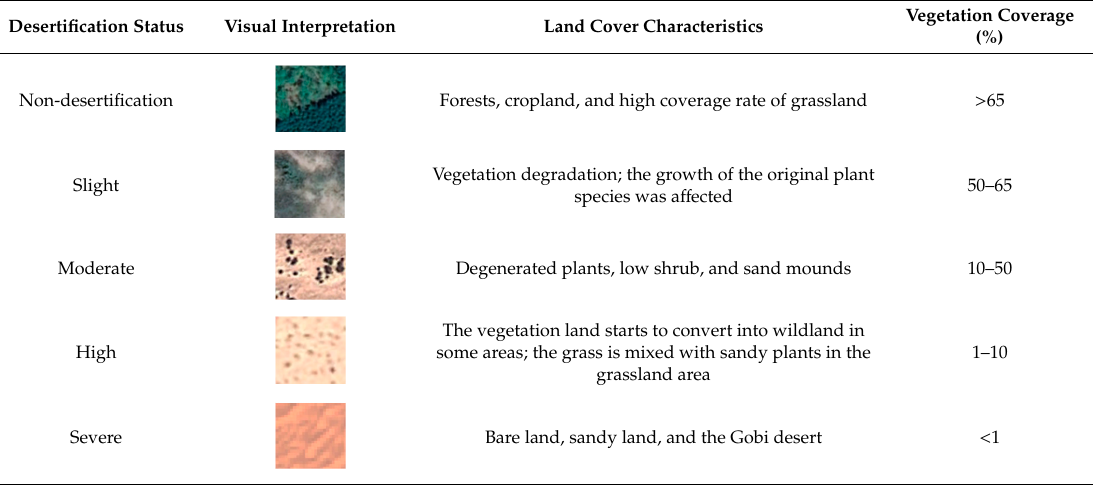
Table 2. Criterion of desertification degrees.